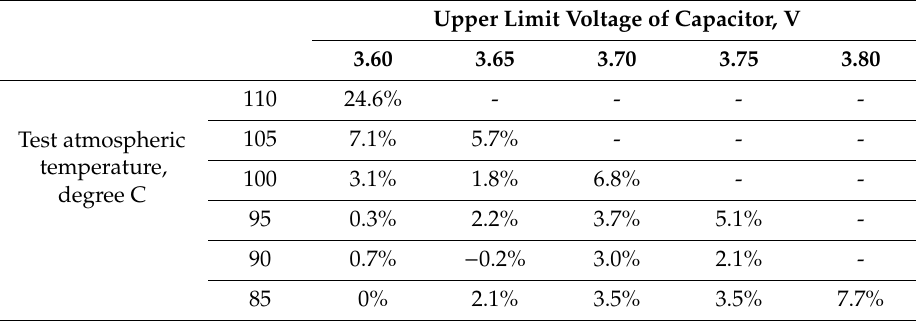
Table 2. Internal resistance increase behavior.